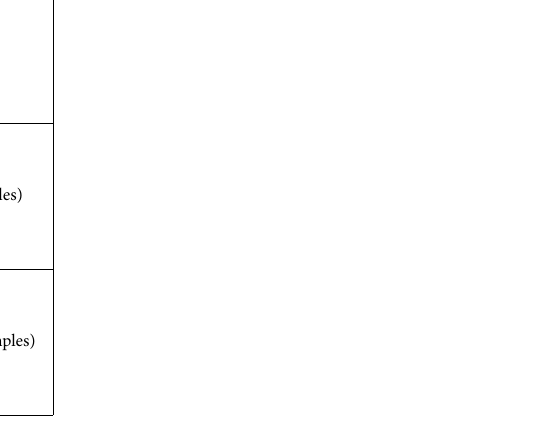
Table 1. The water content in coal samples.